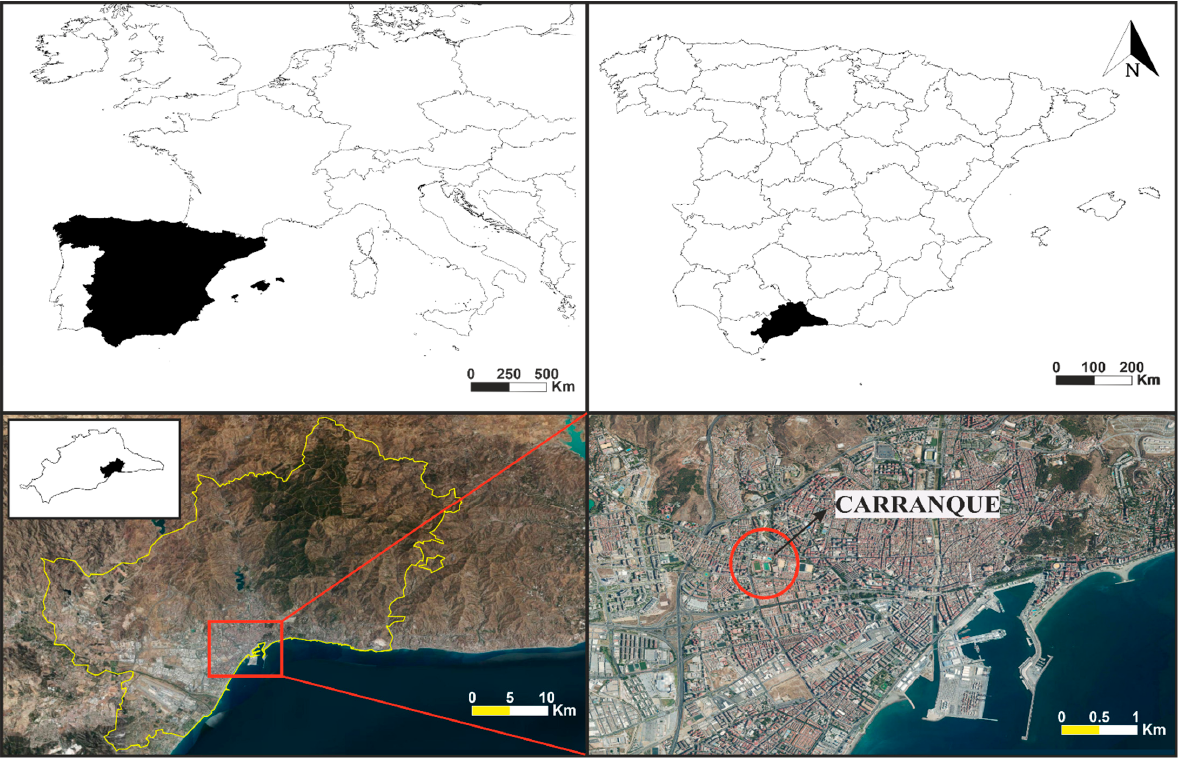
Figure 1. Location of the study area. The upper images show the province of Malaga, standing out within the Iberian Peninsula, and the lower images show the municipality of Malaga in the provincial context and Ciudad Deportiva de Carranque (36°43 ′ N, 4°26 ′ W) within the municipality of Malaga.